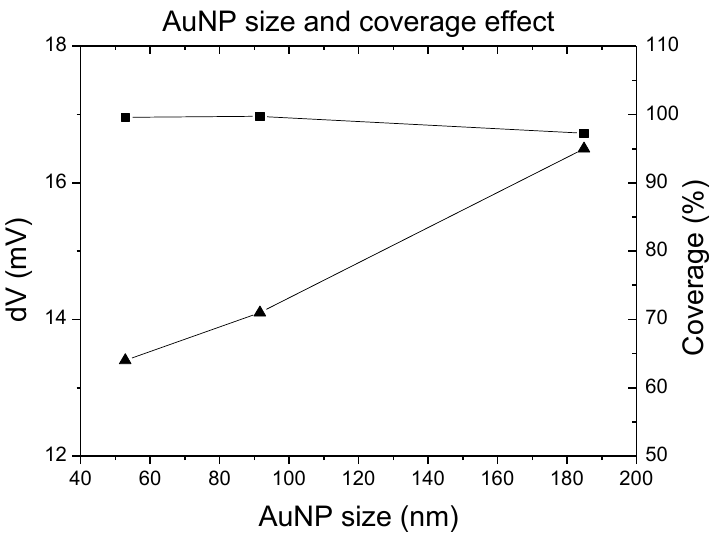
Scheme 1. Schematic presentation of the adsorption of proteins on surfaces with di ff erent sizes of AuNPs.